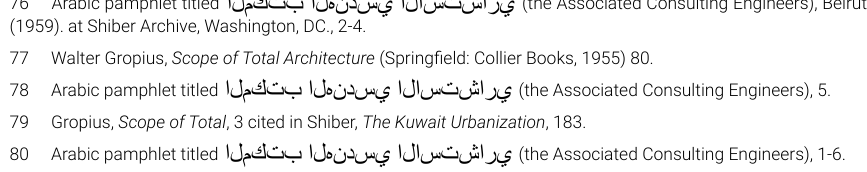
Sample of the first consultancy projects in Lebanon. Source: Arabic print of ACE’s pamphlet, (1959) courtesy to Shiber Ar- chive, Washington, DC. ©